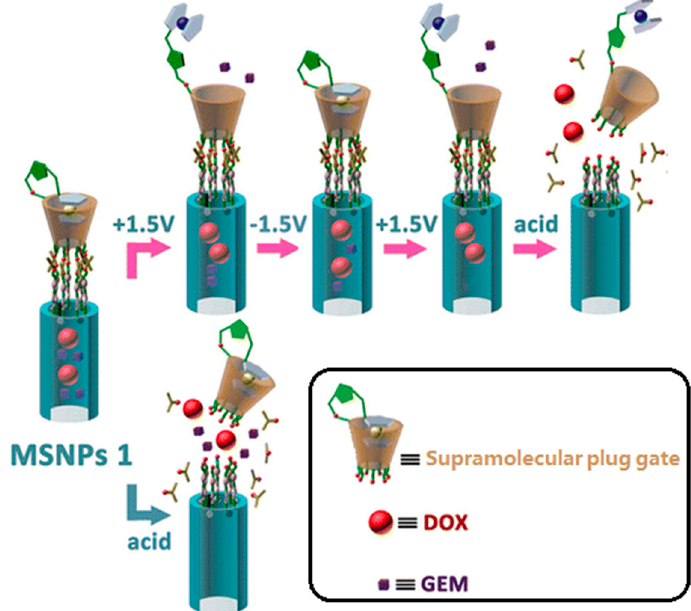
Figure 3. Schematic diagram of a macrocyclic molecule derivative plug gate. DOX, doxorubicin; GEM, gemcitabine. Reprinted with permission from [94]. Copyright 2015 American Chemical Society.